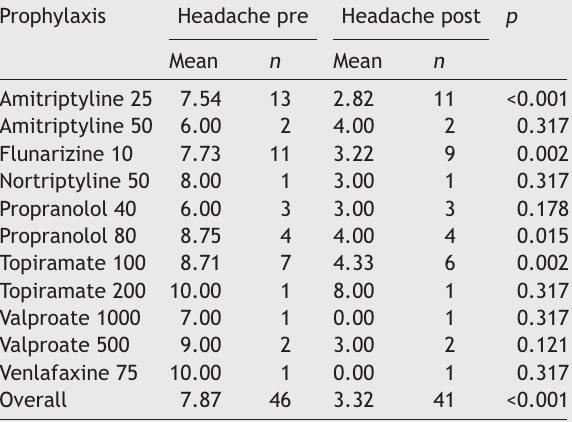
Values obtained with the visual analog scale for headaches, before and after use of prophylactic drug, according to the drug used in patients with